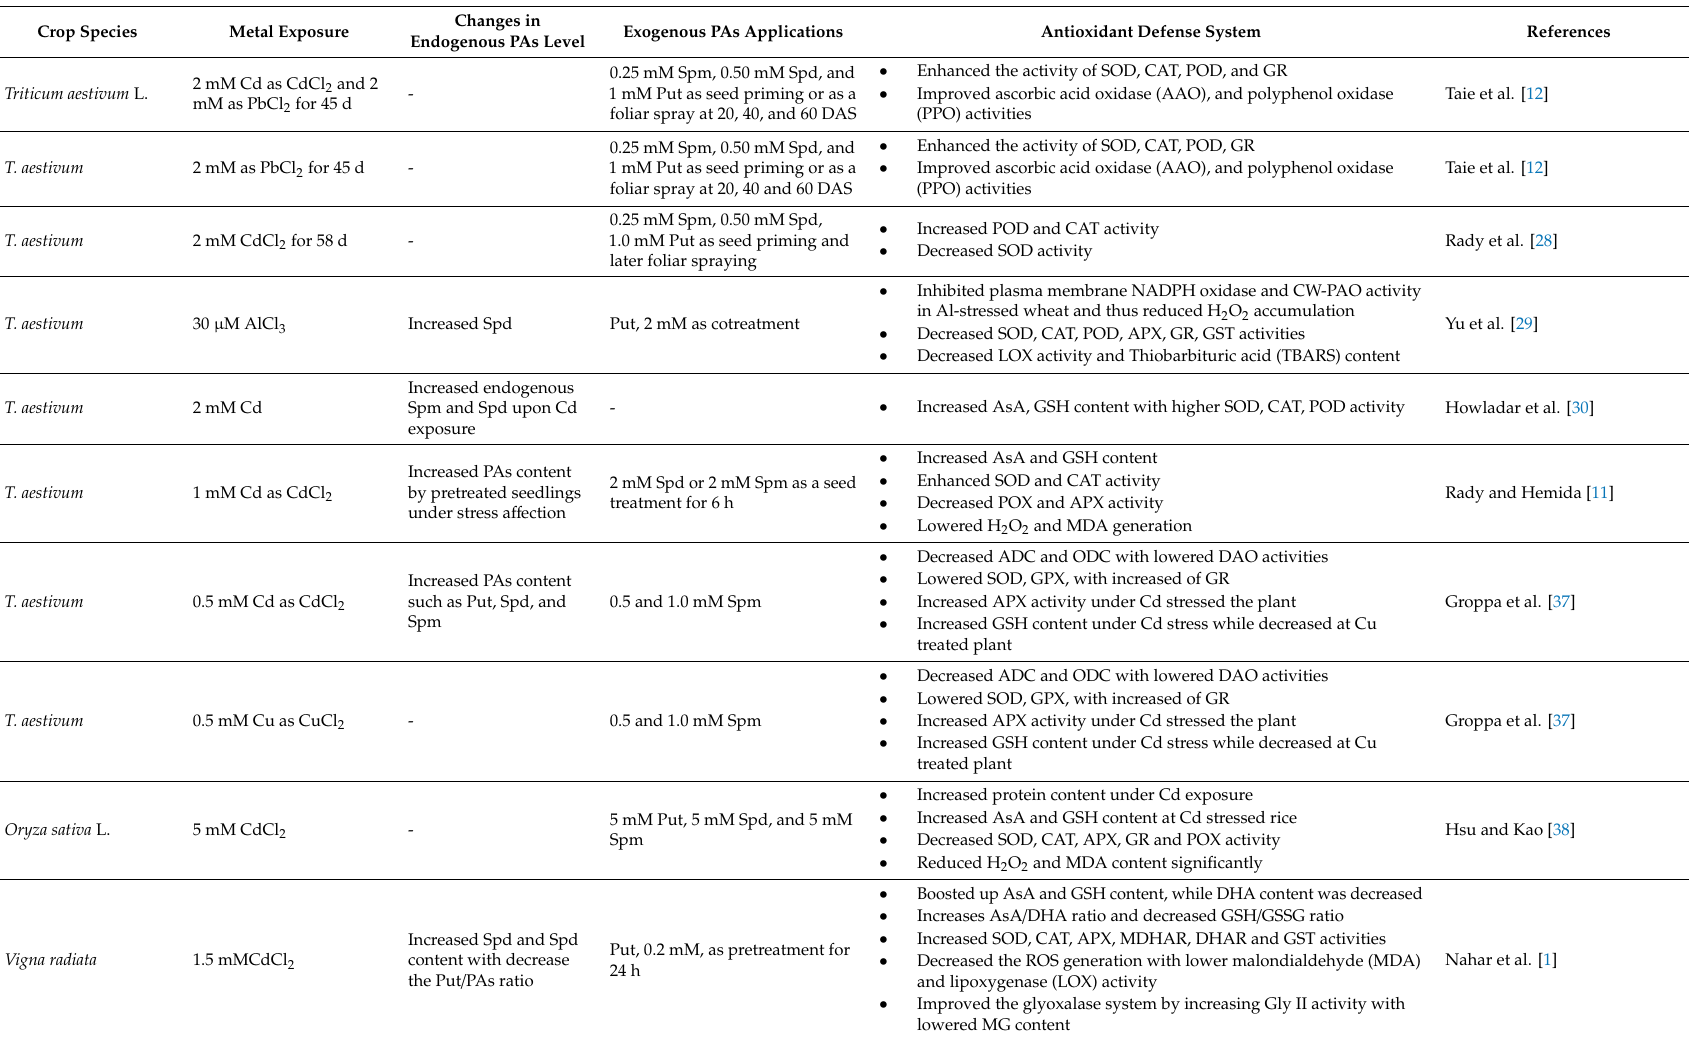
Table 2. Polyamine mediated antioxidant defense in di ff erent plant species under metal / metalloid